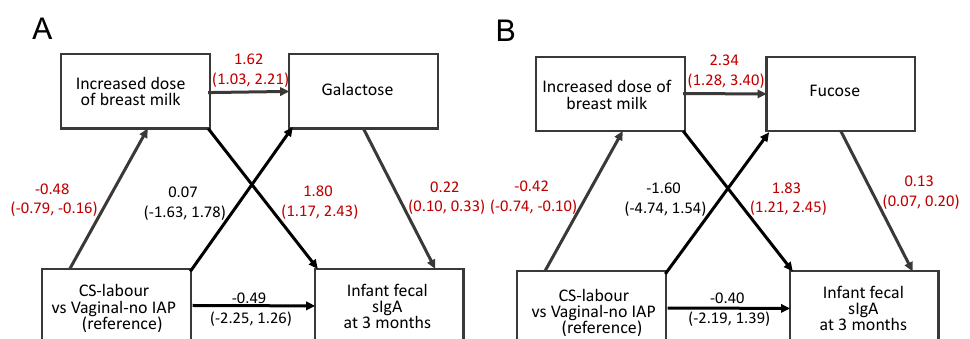
Figure 5. Causal diagram of the association between CS delivery with labor and infant fecal SIgA at 3 months of age, sequentially mediated by increased dose of breast milk, galactose ( A ) or fucose ( B ). Vaginal-no IAP is the reference group. Beta-coefficiency with 95% confidence interval of each path exhibits and significant differences ( p < 0.05) are indicated in